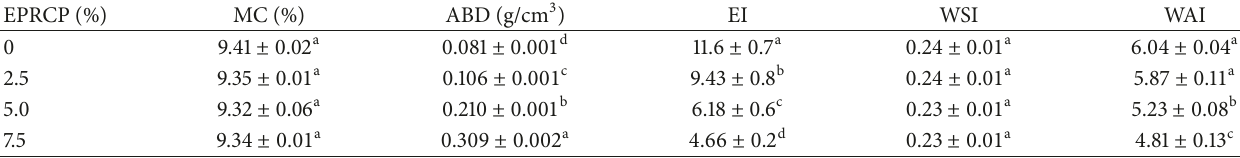
Table 2: Physical properties ∗ of extrudates using encapsulated powder of red cactus pear (EPRCP) as pigment. EPRCP (%)